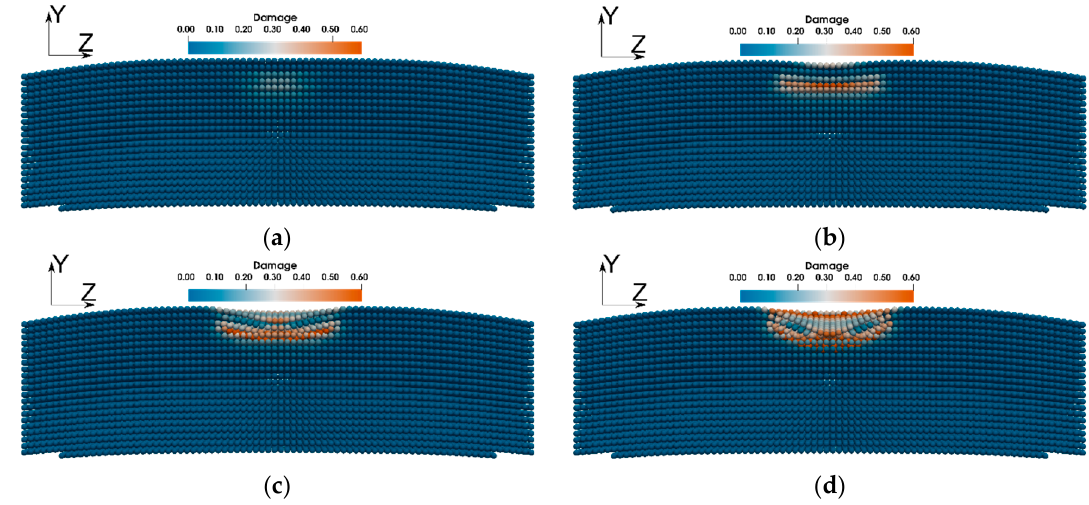
Figure 11. The cross-section (x-z plane) along the middle of the rail head in the transversal direction. Damage is shown in the top half of the model after: ( a ) 37,000; ( b ) 42,500; ( c ) 42,850; and ( d ) 42,884 cycles.